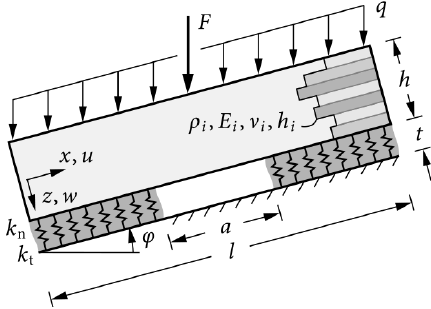
Figure 2. Slab of total thickness h composed of N individual layers. A layer i is characterized by its height h i and its top and bottom coordinates z i and z i + 1 ,